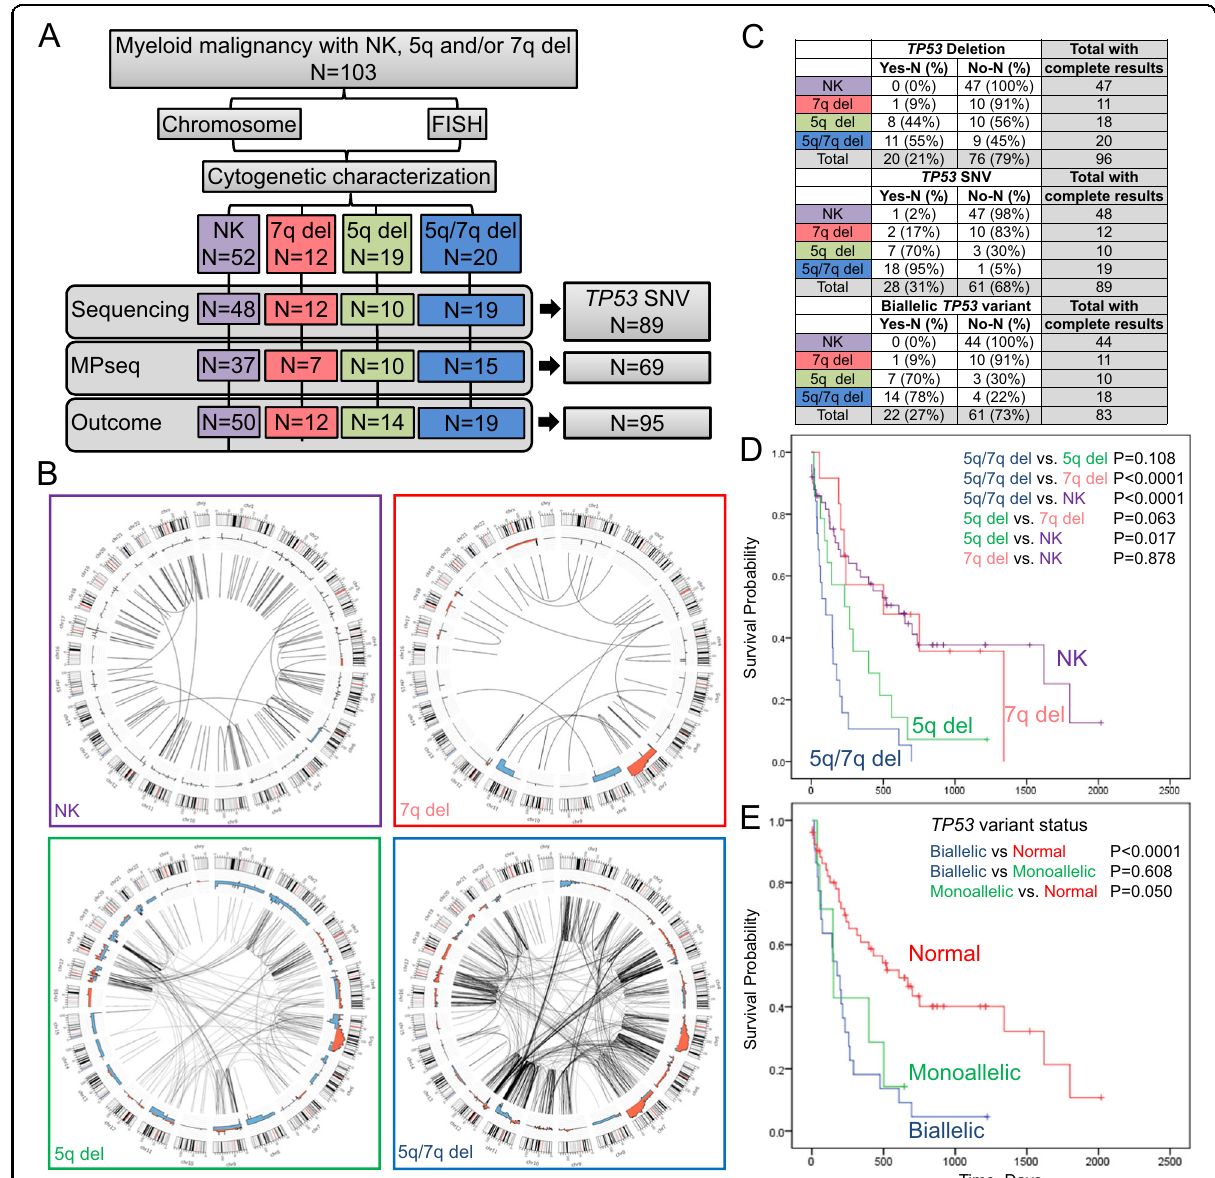
Fig. 1 Myeloid clones with 5q and 7q deletions have complex genomes, biallelic pathogenic/likely pathogenic TP53 variants and poor overall survival. A Schematic of cohort. One hundred and three cases from patients with a diagnosis of a myeloid malignancy and with conventional chromosome and/or FISH studies demonstrating either normal karyotype (NK), 7q deletion (7q del), 5q deletion (5q del), 5q and 7q deletion (5q/7q del). Eighty-nine patients had sequencing (NGS or PCR-based) to identify sequence variants, 69 had MPseq to identify CNV and SV, and 95 samples had data available for assessment of overall survival. B Circos plots depicting CNVs and SVs detected by MPseq in each subtype. The outermost histogram (red) displays genomic losses, with axes rings representing the 20, 40, 60, 80, and 100% number of events per 1Mb window. The next histogram (blue) displays genomic gains, with axes rings representing the 20, 40, 60, 80, and 100% number of events per 1Mb window. Inner links (black) represent translocation and inversion events, with lines indicating positions along the chromosome. C TP53 deletion determined by FISH or MPseq and single nucleotide variant (SNV) status. Biallelic status requires evidence of deletion and SNV, or two pathogenic/likely pathogenic SNVs or one SNV over 80% VAF. D Overall survival probability using NK, 5q and 7q patient status ( N = 95 samples) and in E . TP53 variant status ( N = 81). Survival curves analysis was done using the Kaplan – Meier method and Log rank (Mantel – Cox) was run to determine the difference in the survival distribution among all four study subtypes. Eight patients were removed due to lack of follow-up data. Survival and AML diagnosis date was obtained from the medical record. The date of diagnosis re fl ects the original AML diagnosis. In D , 5q/7q del (blue line), 5q del (green line), 7q del (red line), and NK (purple line). In E , biallelic TP53 variants (blue line), monoallelic TP53 variants (green line), and normal TP53 status (red